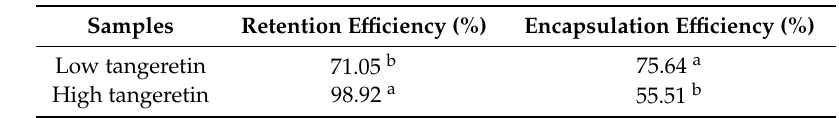
Table 2. Retention e ffi ciency and encapsulation e ffi ciency of tangeretin in citrus pectin and sodium alginate matrix